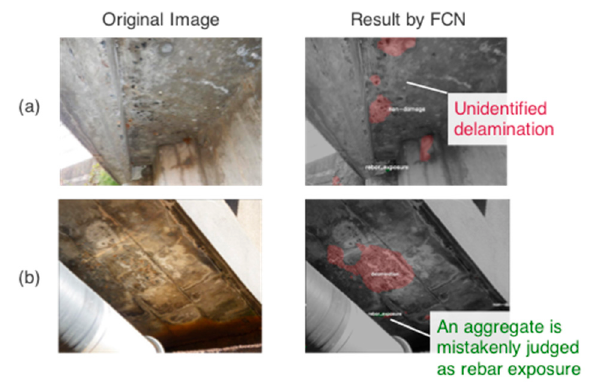
Figure 4. A part of the validation result by FCN: ( a ) wrong identification of delamination; ( b ) false